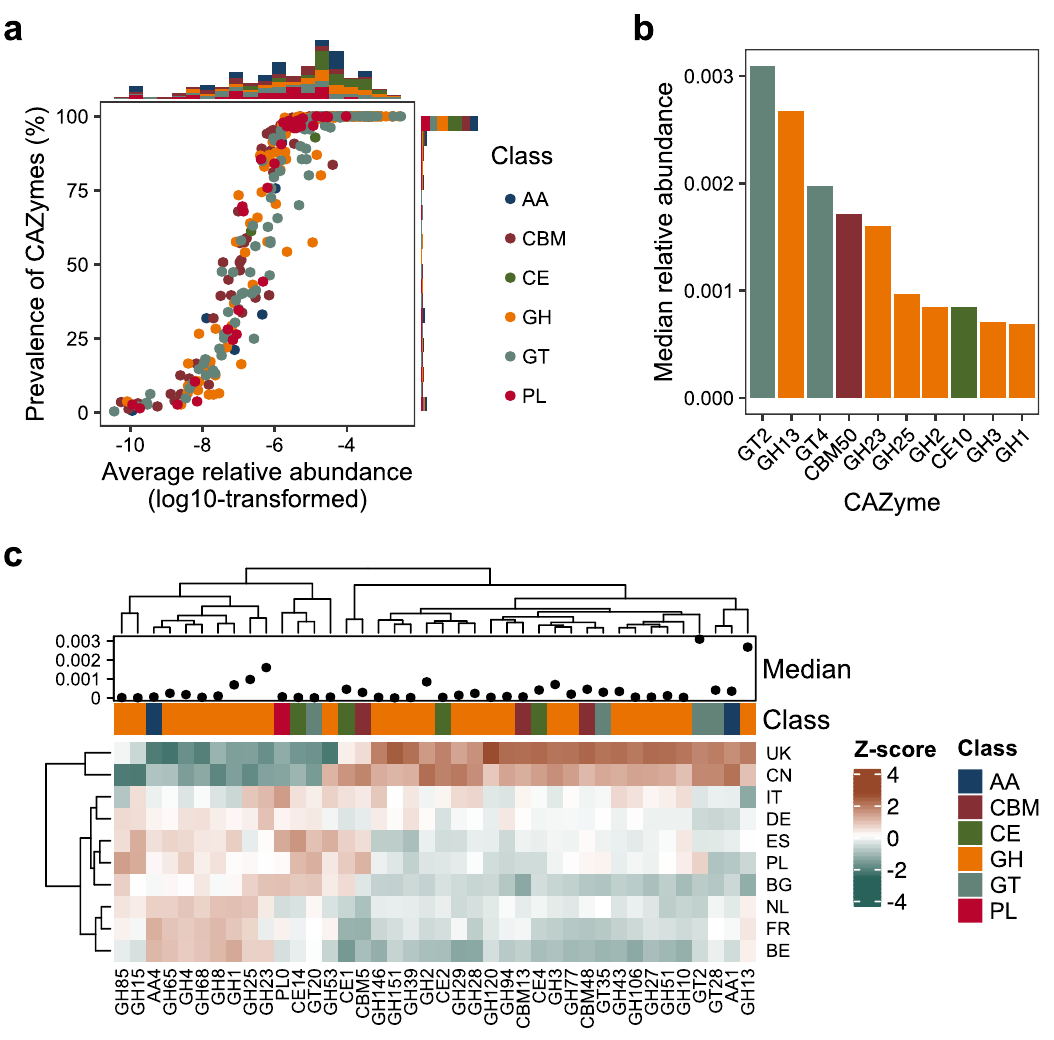
Fig. 3 Distribution of CAZymes in chicken gut samples. a Median relative abundance and prevalence of the 371 CAZyme subclasses found in chicken gut samples. b The top ten most abundant CAZyme subclasses found in the chicken gut microbiome. The height of each bar is the median value of the relative abundance of each CAZyme subclass. c The top 40 CAZyme subclasses with abundance variations among the ten countries. Color: Z -scores of the median values of the relative